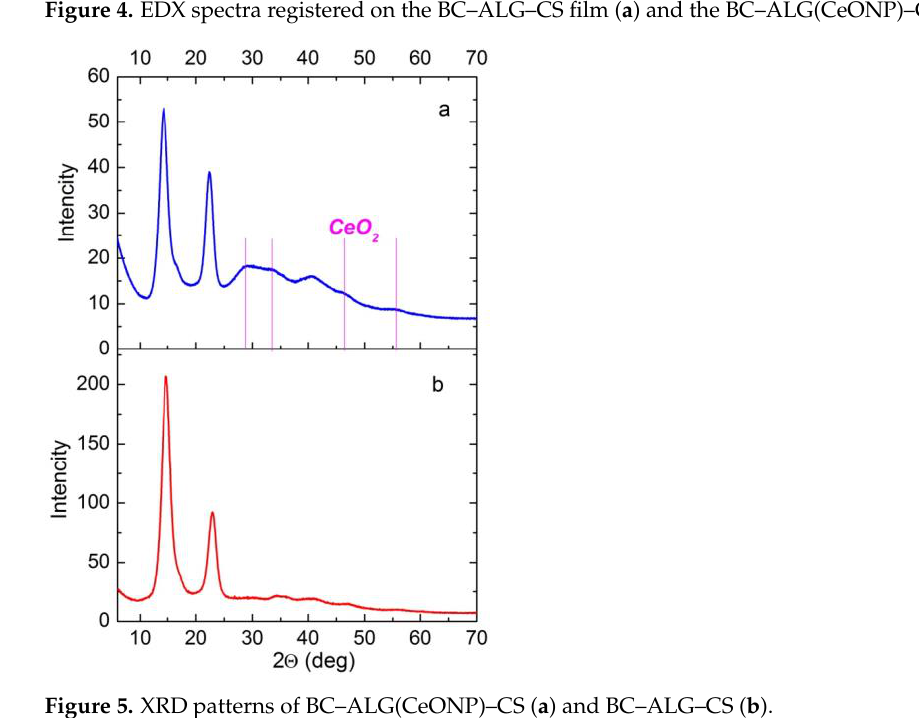
Figure 5. XRD patterns of BC–ALG(CeONP)–CS ( a ) and BC–ALG–CS ( b ).